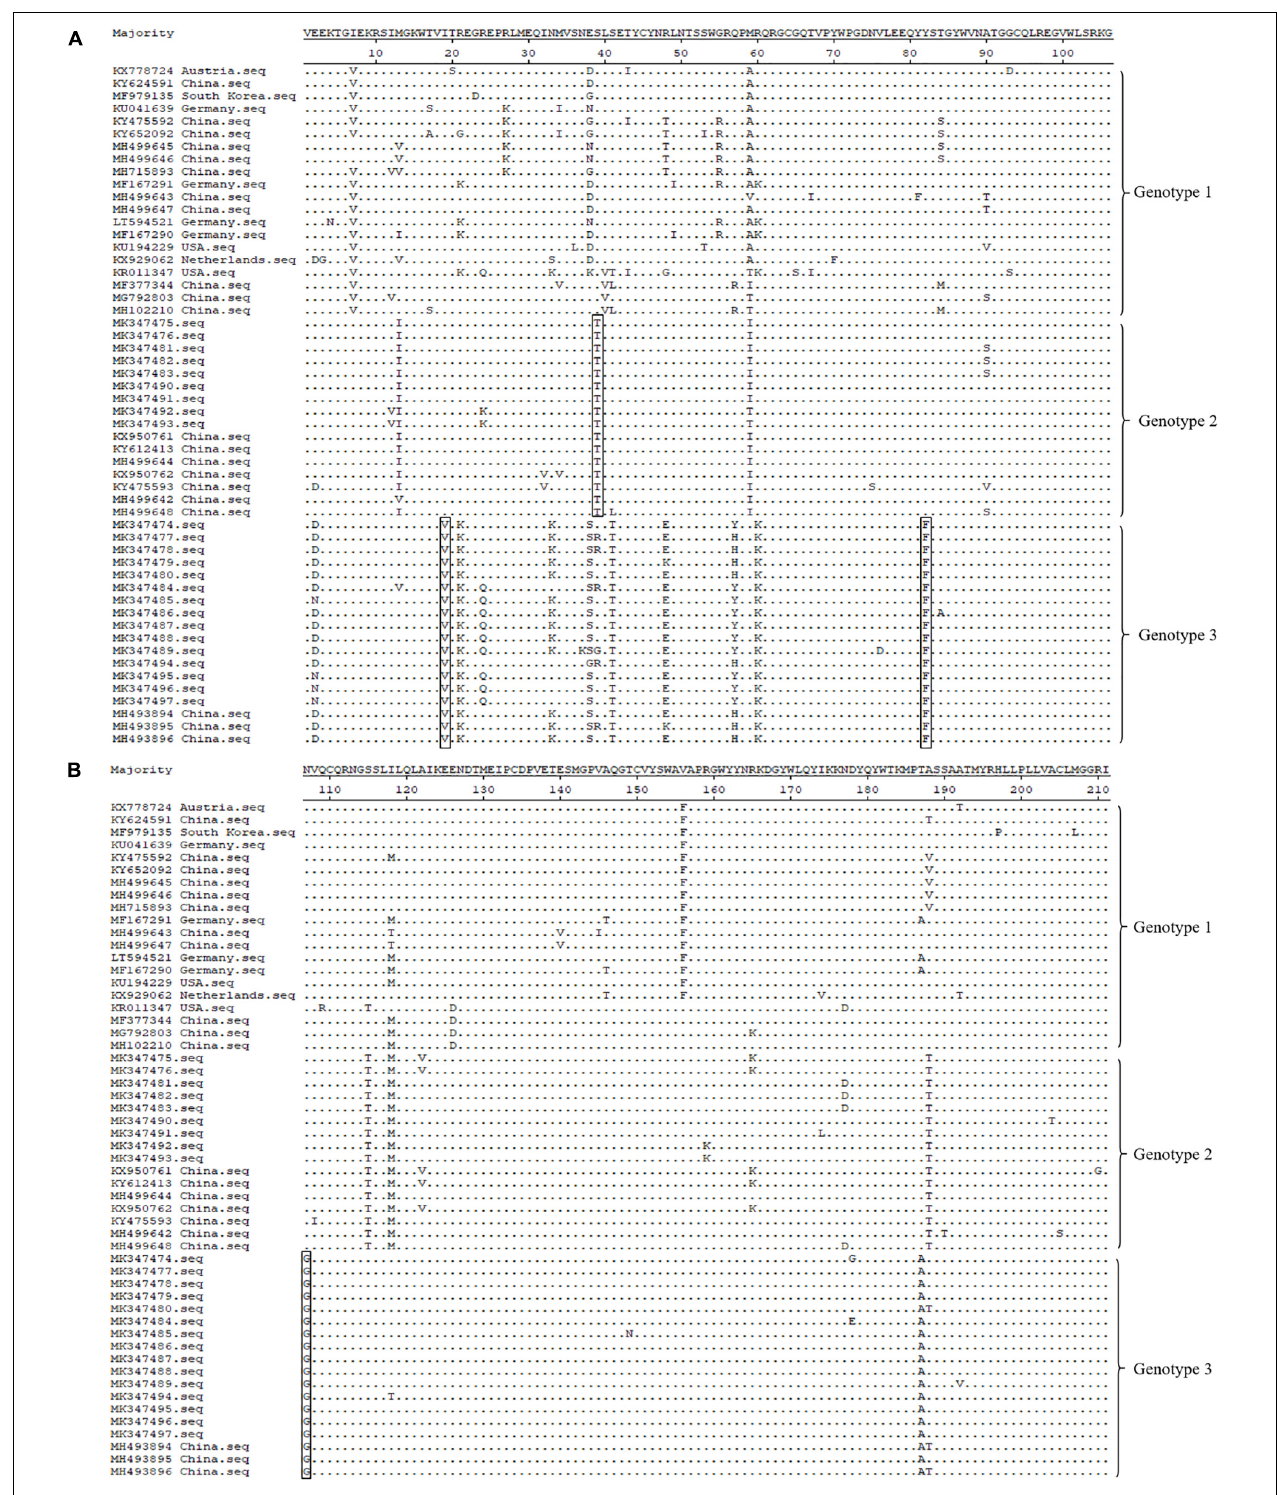
FIGURE 4 | Molecular feature analysis of APPV E2 protein (partial, 211 amino acids). Four specific amino acid mutation sites (I19V, S39T, Y82F, and N107G), which are used for different APPV genotype divisions, are depicted using rectangular boxes. Panel (A) displayed is the alignment of the 106 amino acid sequence at the front end of E2 gene. Panel (B) displayed is the alignment of the 105 amino acid sequences at the end of E2 gene.